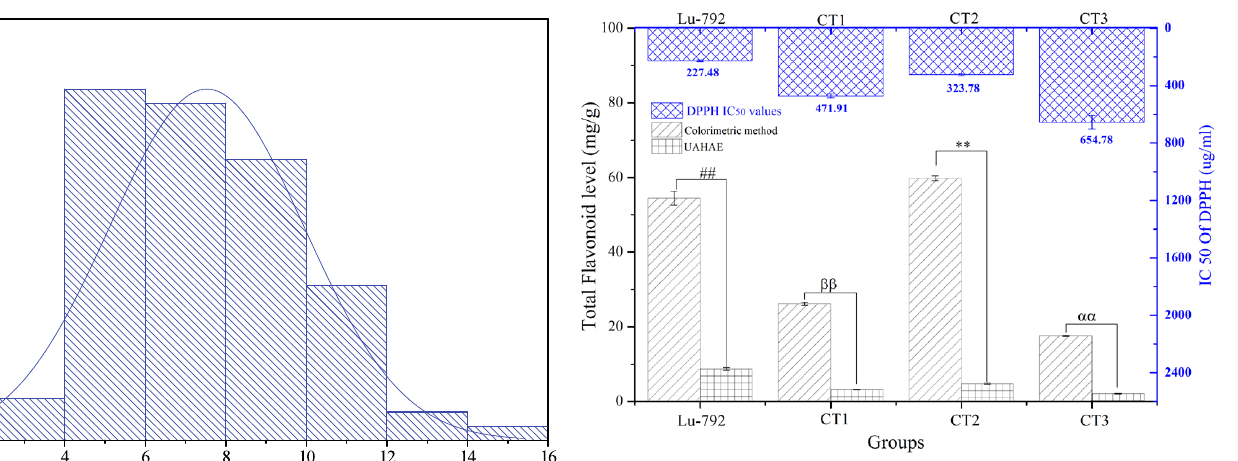
Fig. 4: Determination of total flavonoids by the colorimetric method and UAHAE in mulberry tea extracts and their DPPH radical scaveng- ing activities. Commercial mulberry leaves tea (CT1, CT2, CT3), Lu-792: the source of C1, ## p< 0.01, ** p< 0.01, aa p< 0.01, bb p< 0.01 compared to the colorimetric